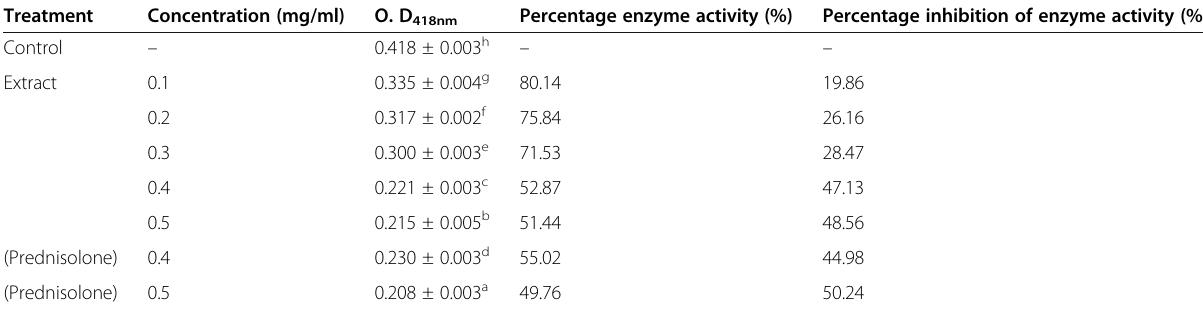
Table 4 Effect of flavonoid-rich extract of Peltophorum pterocarpum stem back on phospholipase A